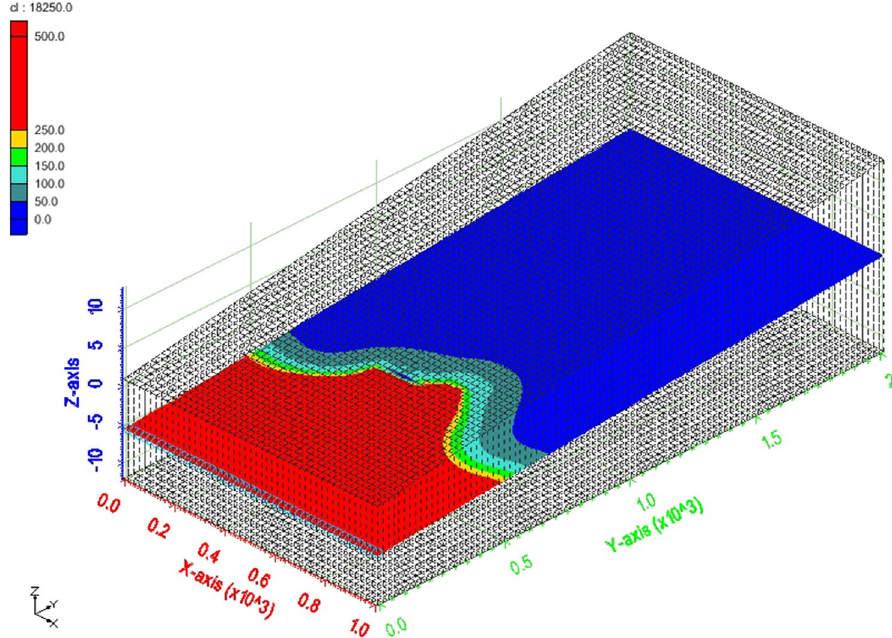
Fig. 6 Results of seawater intru- sion for the optimal solution of cutoff wall